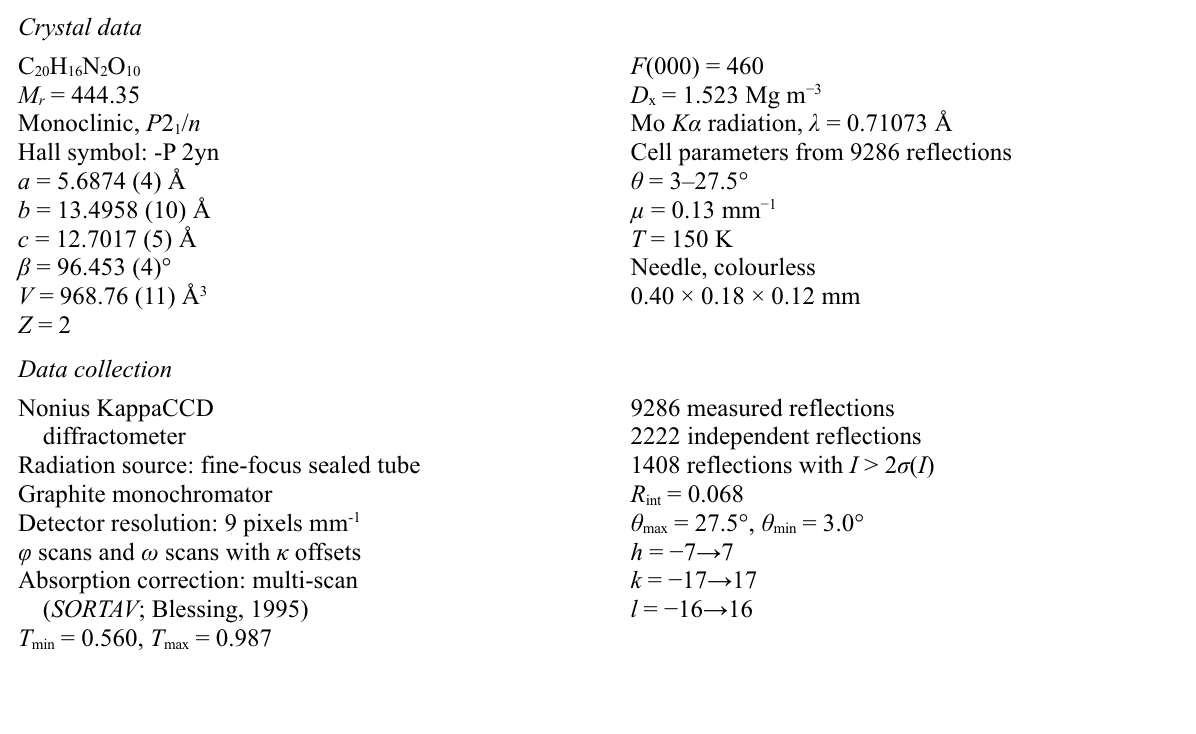
Figure 2 The molecular structure of (I) showing another component of disorder in the cyclohexene ring. Displacement ellipsoids drawn at the 30% probability level. Unlabeled atoms are related by the symmetry operator (1 - x , 1 - y , 1 - z ). trans -Cyclohex-2-ene-1,4-diyl bis(4-nitrophenyl)